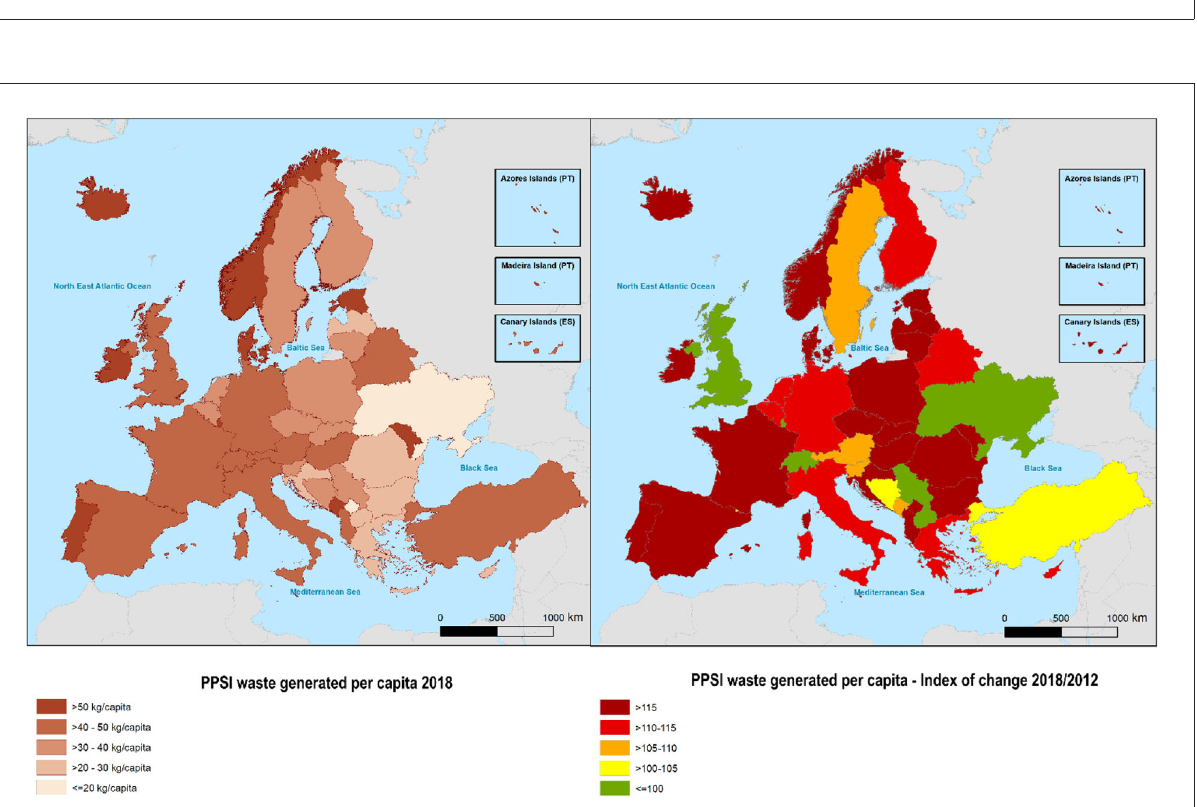
FIGURE3 PPSI waste generated (kg per capita) in 2018 (left) and index of change 2018/2012 (right) in the EU-27 plus Iceland, Liechtenstein, Norway, Switzerland, Turkey, and the UK (estimates for other countries displayed are based on World Bank data). PPSI, plastic packaging and small non-packaging plastic